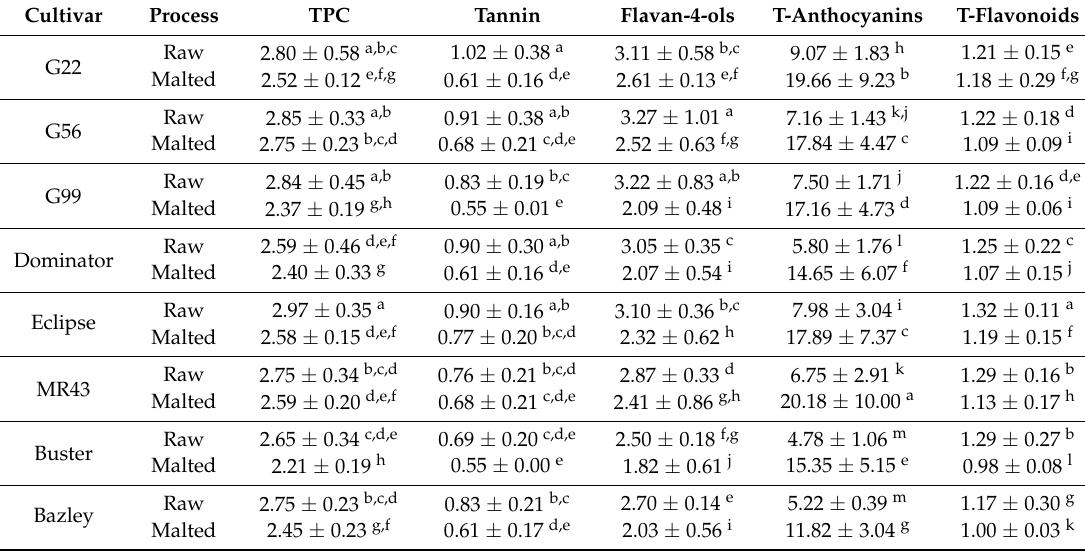
Table 4. Mean comparison of grain phenolics and antioxidant activity among Australian sorghum cultivars. Values are means ± SD ( n =